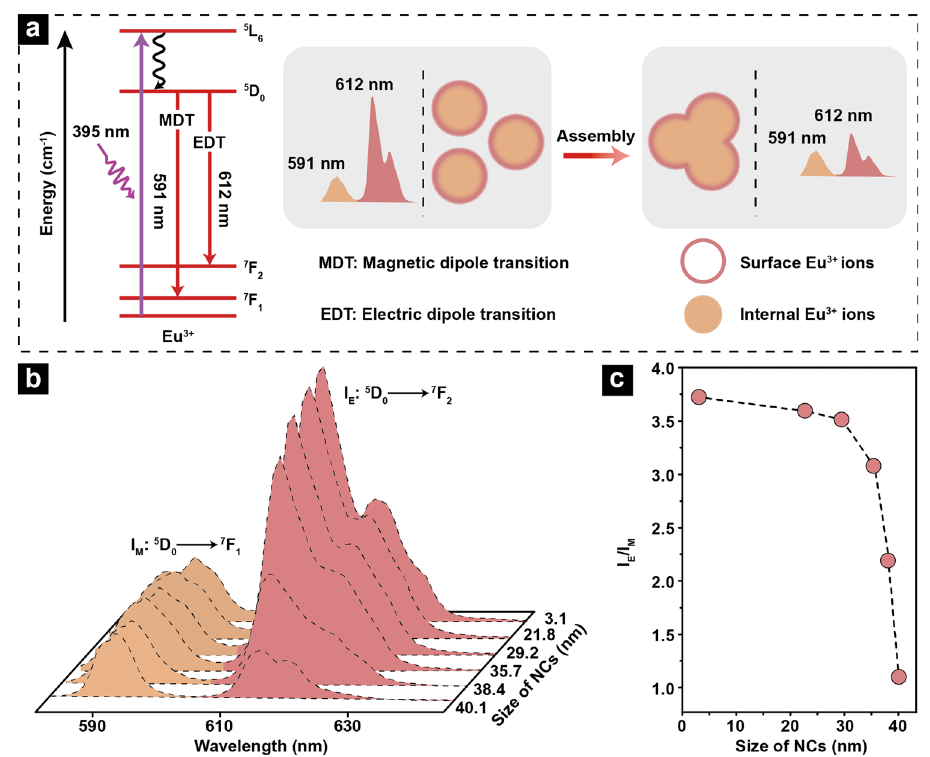
Fig. 3 Working principle of Eu 3 + used as luminescent probe. a Illustration of different electron transition pathways in Eu 3 + and intensity evolutions of electric-dipole (612 nm) and magnetic-dipole (591 nm) transitions during NCs growth. b Evolution of PL spectra and c I E /I M value of Eu 3 + in NCs with different sizes. 395 nm light was used as excitation